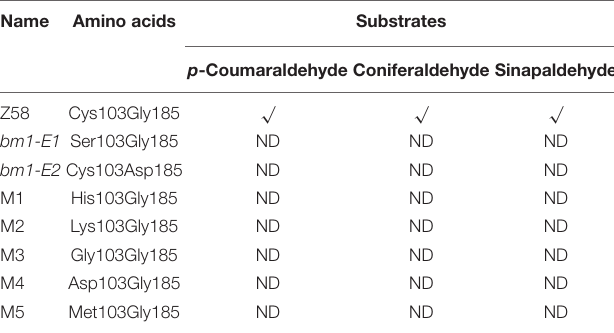
TABLE 1 | Enzymatic activity of ZmCAD2 and its mutated versions in different substrates in vitro . Name Amino